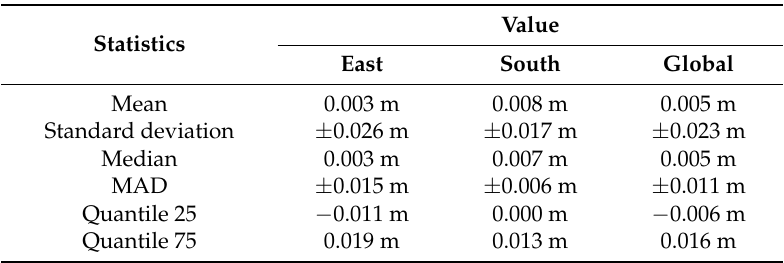
Figure 8. QQ-plots of relative discrepancies between MLS and TLS in the “Alcazar” fortress for the: east walls ( left ) and south walls ( right ). Table 5. Robust statistical descriptors associated to relative discrepancies.